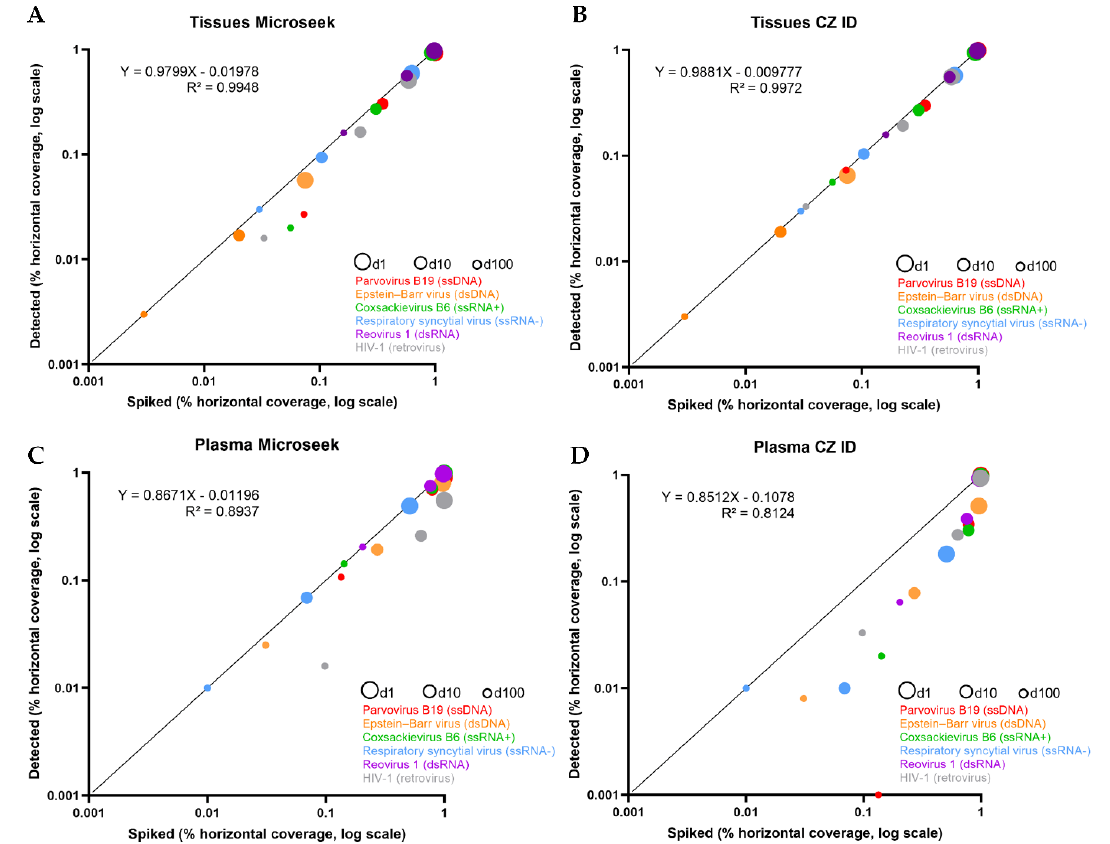
Figure 2. Detection of six known viruses (spiked vs. detected). Scatter plots of spiked ( X axis) vs. detected ( Y axis) percentage horizontal coverage for the 6 known viruses of the study, for the Tissues ( A , B ) and Plasma ( C , D ) experiments. Each virus is depicted by 3 points, corresponding to the d1 (large circles), d10 (intermediate circles) and d100 (small circles) experiments, and is associated with a specific color (red: Parvovirus B19; orange: Epstein-Barr virus; green: Coxsackievirus B6; blue: HRSV; purple: Reovirus-1; grey: HIV-1). The identity line (Y = X) is represented in